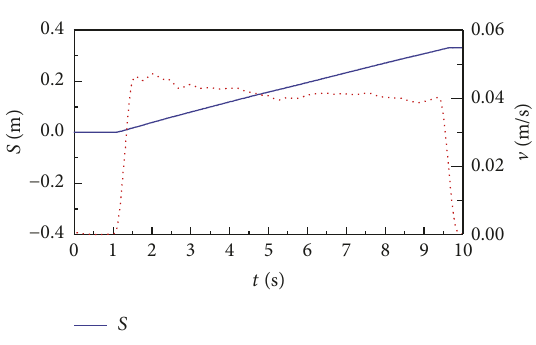
Figure 6: Displacement and velocity of the beam.